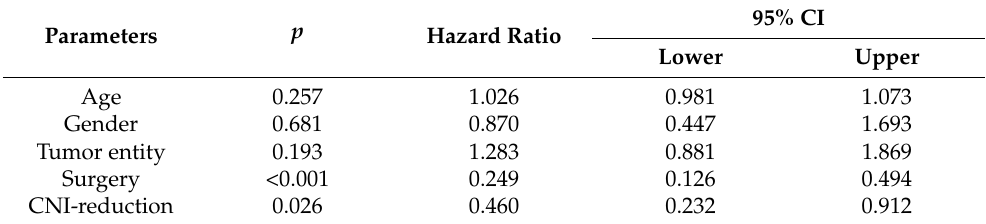
Table 3. Potential